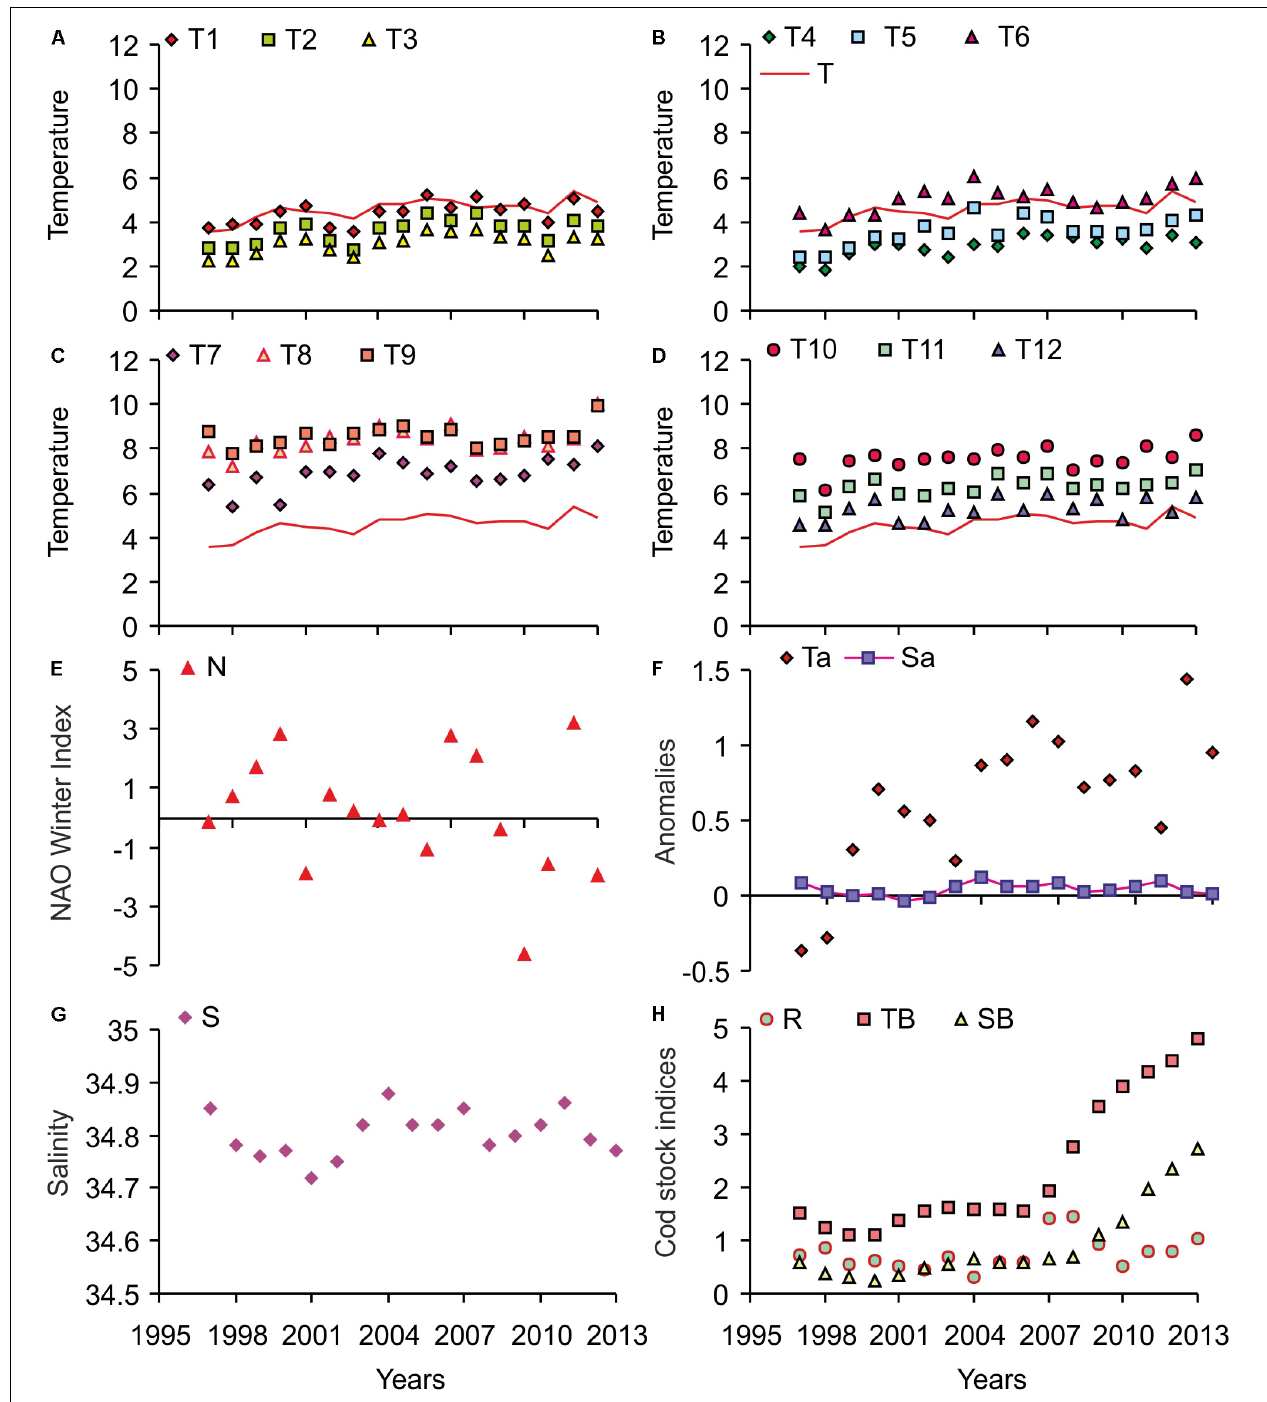
FIGURE 2 | Variations in abiotic and biotic factors in 1997–2013. T1–T12 – mean monthly water temperature at stations 1–3 of the Kola section in January (T1)–December (T12), T – averaged year water temperature (A–D) , N – North Atlantic Oscillation Winter Index (E) , Ta – temperature anomaly (F) , S – salinity (G) , Sa – salinity anomaly (F) , R – cod recruit biomass, TB – cod total biomass, SB – cod spawning biomass (H) . Cod stock indices are expressed in million metric tons.